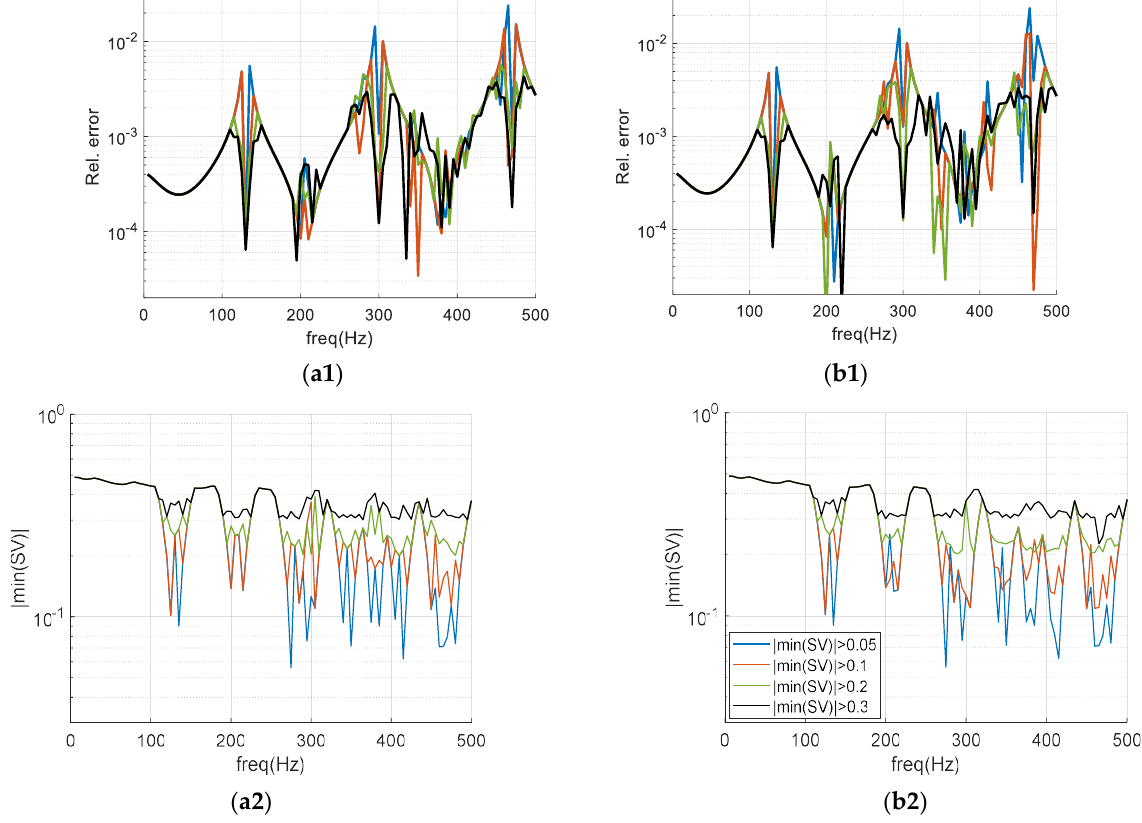
Figure 9. Relative error ( a1 , b1 ) and smallest singular value ( a2 , b2 ) computed for the two algorithms ALG1 ( a1 , a2 ) and ALG2 ( b1 , b2 ), considering different acceptable values for min(SV) of 0.05, 0.1, 0.2 and 0.3. The same color pattern is used for all figures.